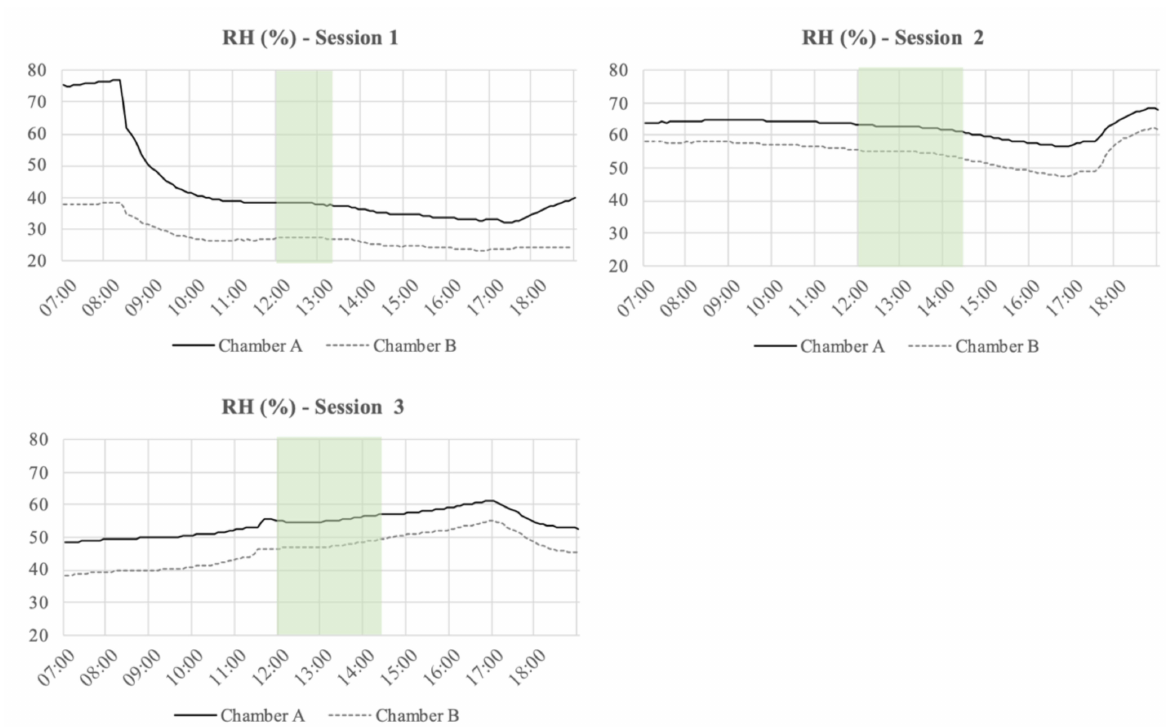
Figure 6. Relative humidity (RH) (%) measured during the three sessions from 7.00 to 19.00 every 5 min. The highlighted section is the period when the participants executed the experiment and filled the questionnaires.